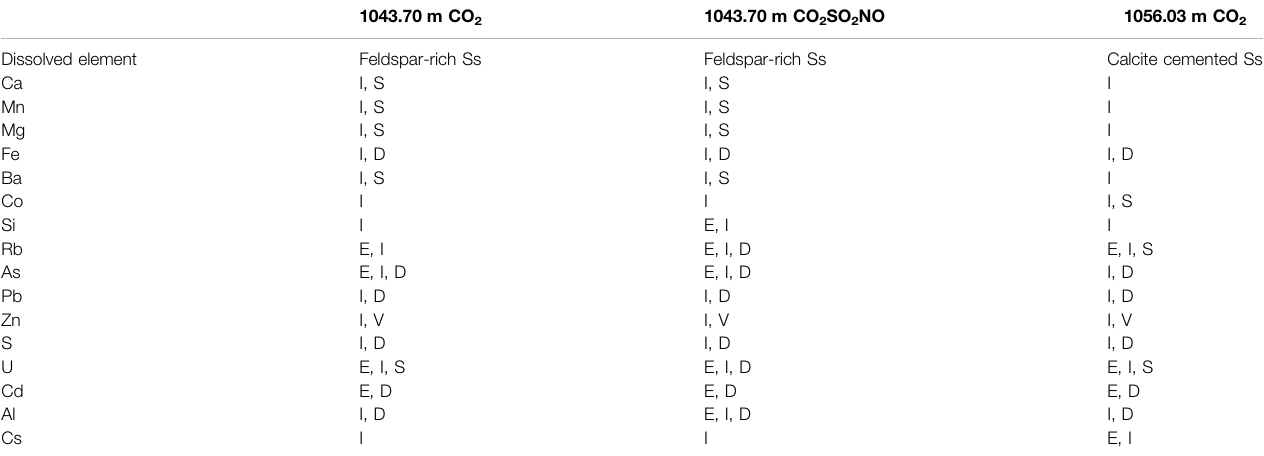
TABLE 5 | Summary of batch experiment trends of dissolved ions after CO 2 addition (unless otherwise speci fi ed). I = increase in concentration after CO 2 addition. I, S = increase and stabilization; D = decrease; I, D = increase and then decrease; V = varying; E = increase before CO 2